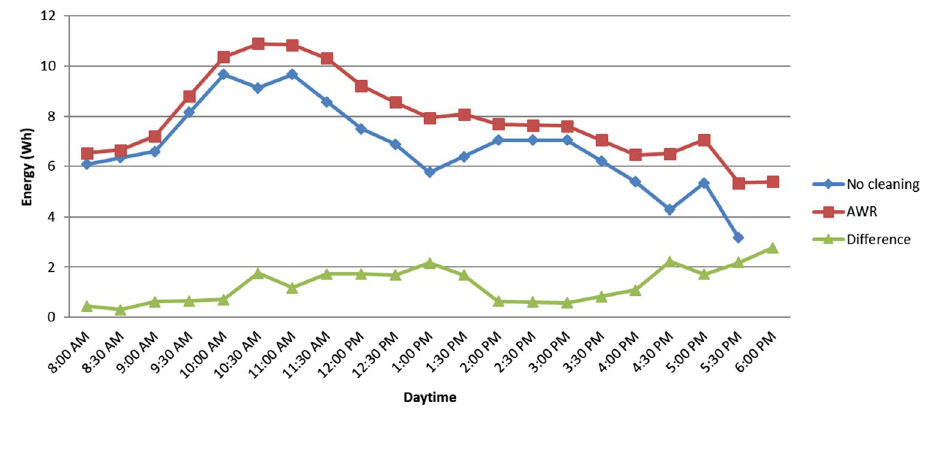
Fig. 9 Percentage difference in current and voltage against average amount of wet sand